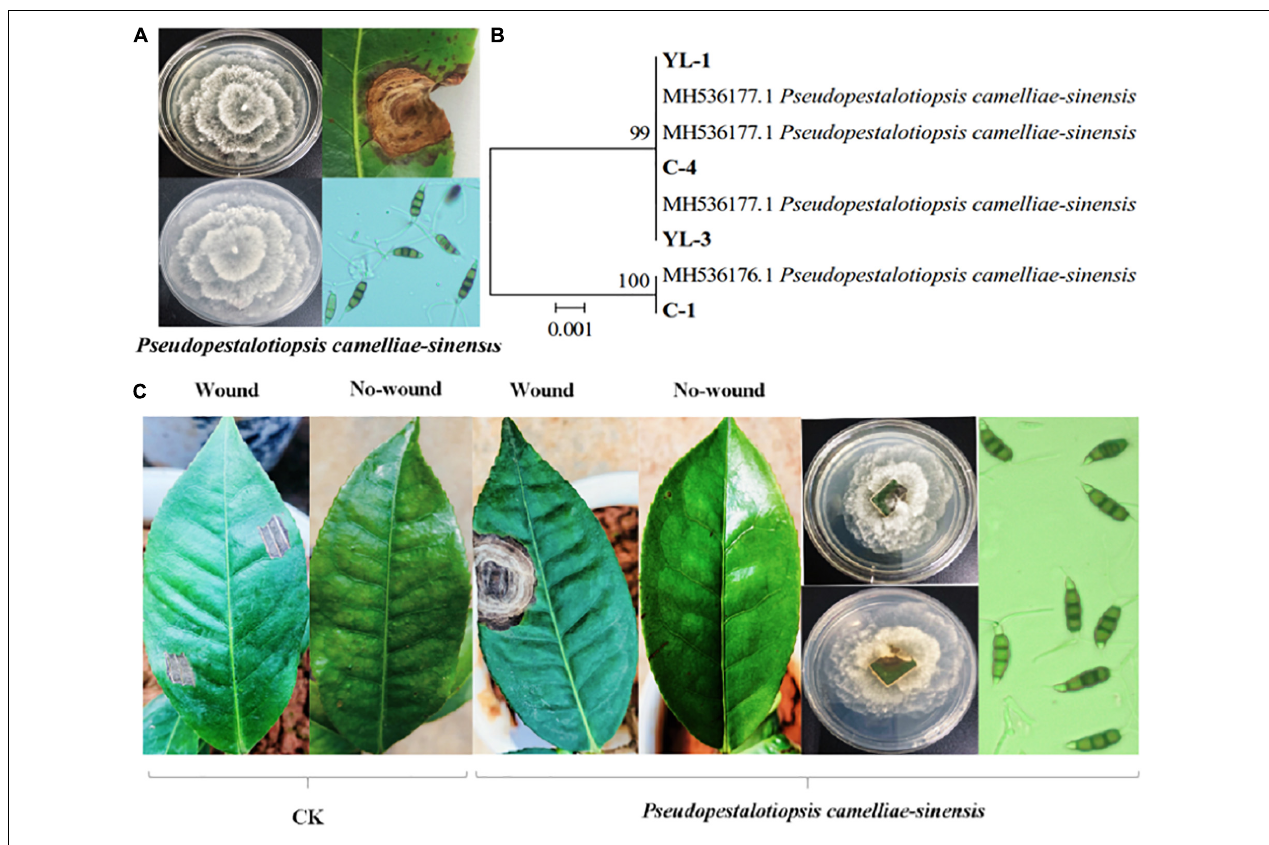
FIGURE 1 | Identification of the pathogen causing tea gray blight and pathogenicity tests. Colony morphology of, symptoms caused by, and conidia of Ps. camelliae-sinensis. (A) Hierarchical clustering based on β -tubulin gene sequences of pathogens (B) . In - vitro pathogenicity tests of tea leaves (C) .